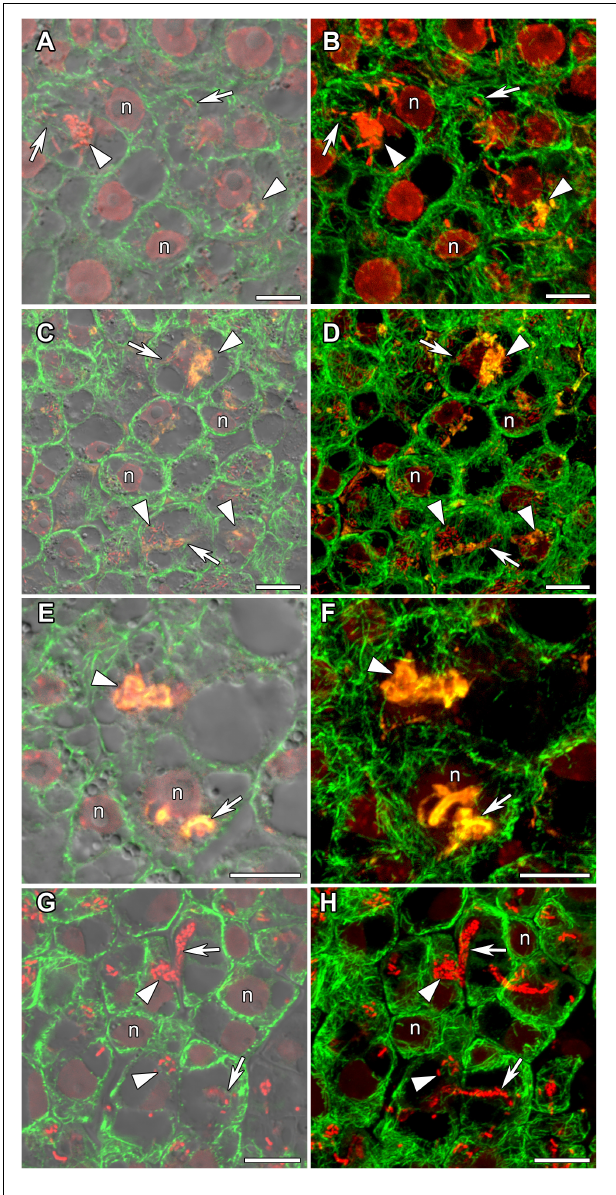
FIGURE 3 | Microtubule organization in meristematic cells of G. max (A,B) , G. soja (C,D) , P. vulgaris (E,F) , and L. japonicus (G,H) nodules. n, nucleus; triangles indicate mitotic figures, arrows indicate infection threads. Confocal laser scanning microscopy of (A–F) 50 µ m and (G,H) 35 µ m longitudinal vibratome sections. Immunolocalization of tubulin (microtubules), green channel; DNA staining with propidium iodide (nuclei and bacteria), red channel. (A,C,E,G) Merged images of a single optical section of differential interference contrast and green and red channels. (B,D,F,H) Maximum intensity projections of 30 optical sections in green and red channels. Scale bar = 10 µ m.